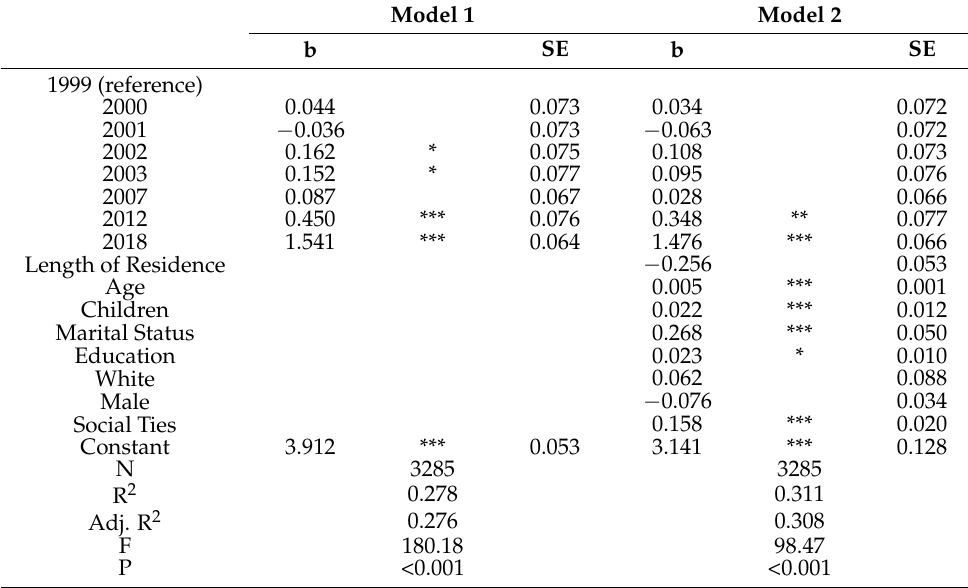
Table 3. Change in Community Satisfaction Over Time.